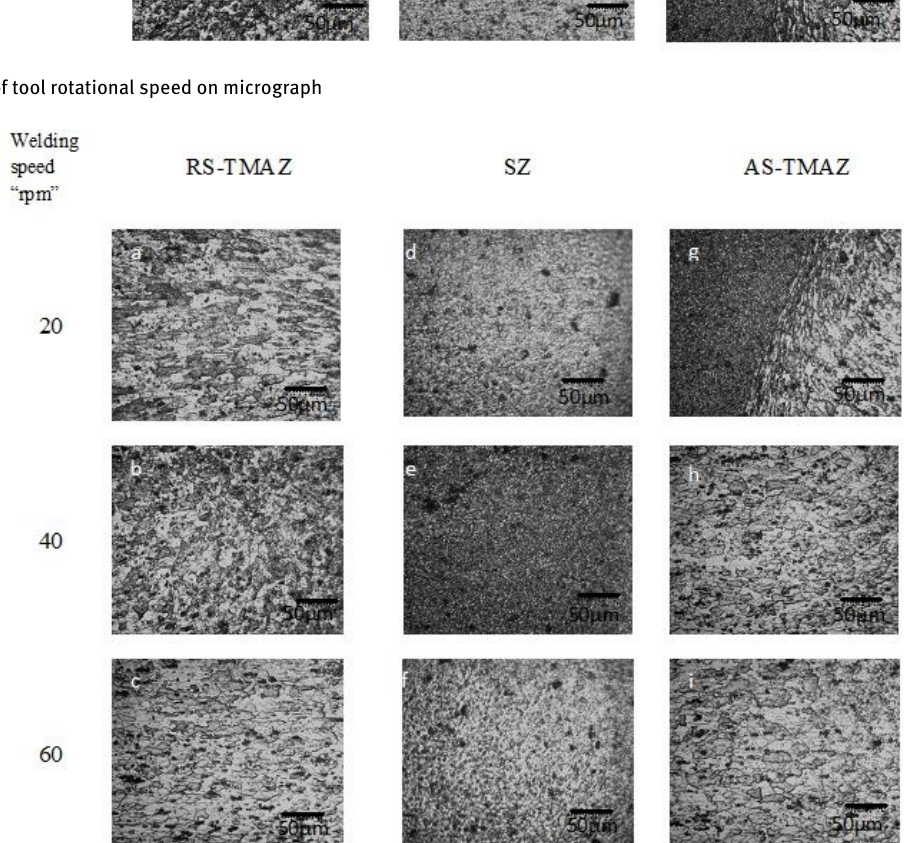
Figure 17: Effect of welding speed on